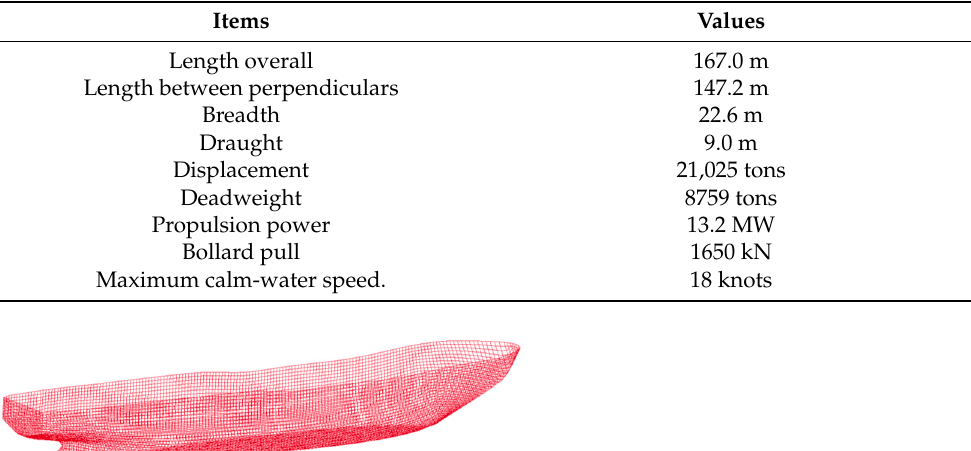
Table 5. Primary dimensions of MV Xue Long.